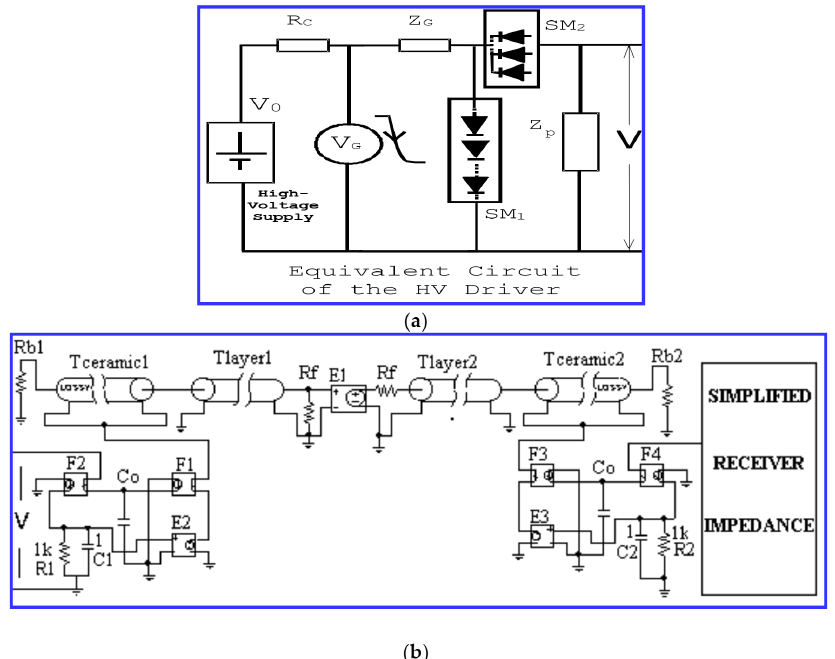
Figure 7. Scheme of a practical option we propose for circuital modeling (in P-Spice) of ultrasonic transceivers under pulsed high-power capacitive driving, for intermediate frequency ranges: ( a ) HV capacitive driver, ( b ) piezoelectric subsystems with mechanical piezoelectric losses in E/R